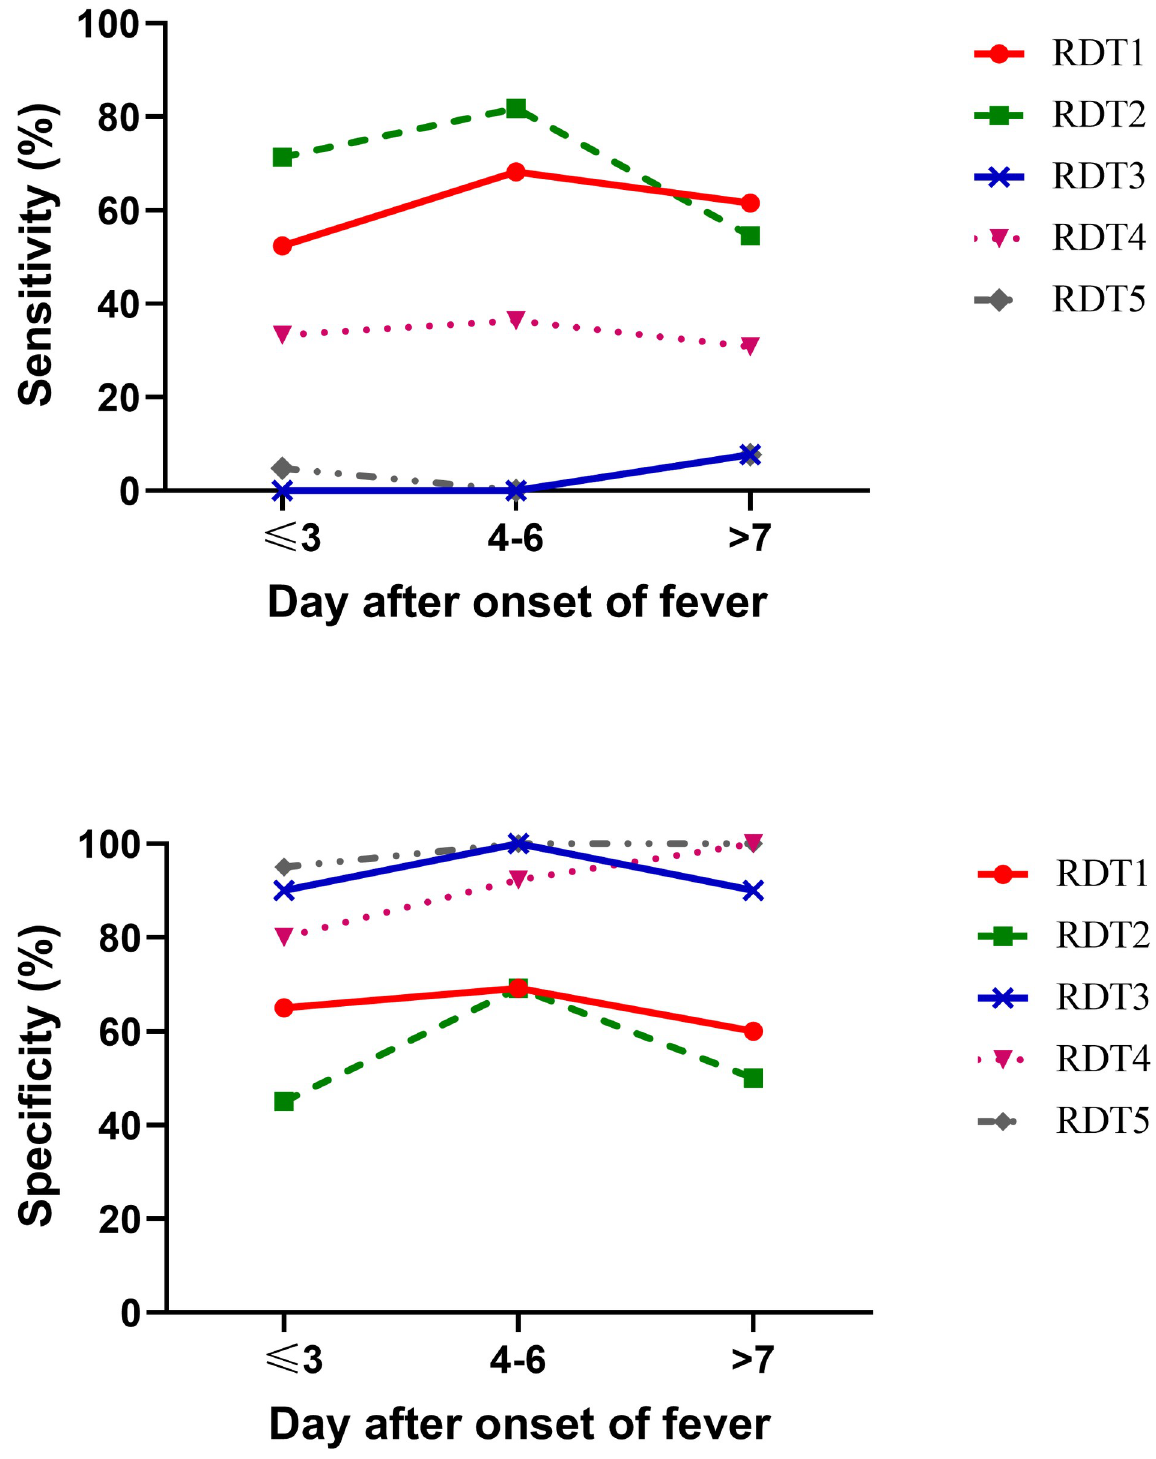
Fig 3. Sensitivity and specificity of five rapid diagnostic tests at different days post onset of fever. (A) The sensitivity (y-axis) relative to day after onset of fever (x-axis). (B) The specificity (y-axis) relative to day after onset of fever (x-axis).